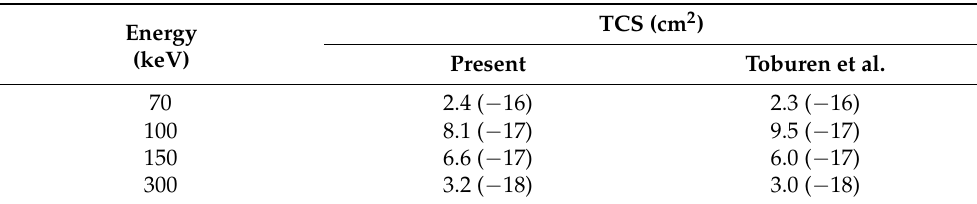
Table 1. The present total cross-section (TCS) data with Toburen et al. [16]. Numerals in brackets indicate the power of 10. The experimental error in the present data is ~20%.